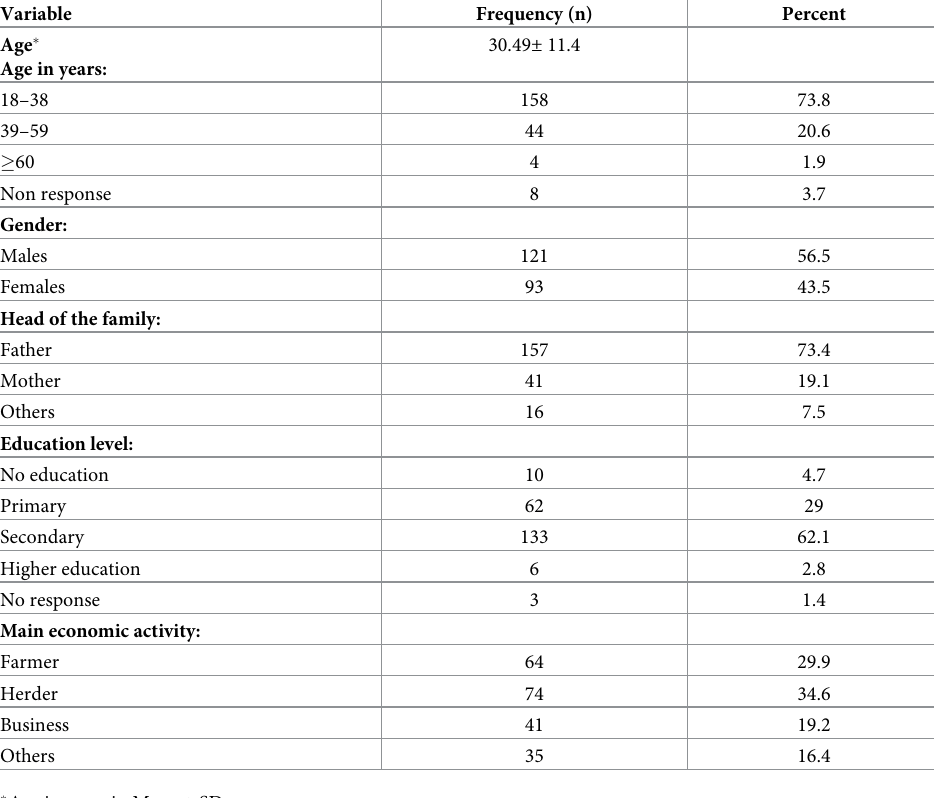
Table 1. Socio-demographic characteristics of the respondents (N =